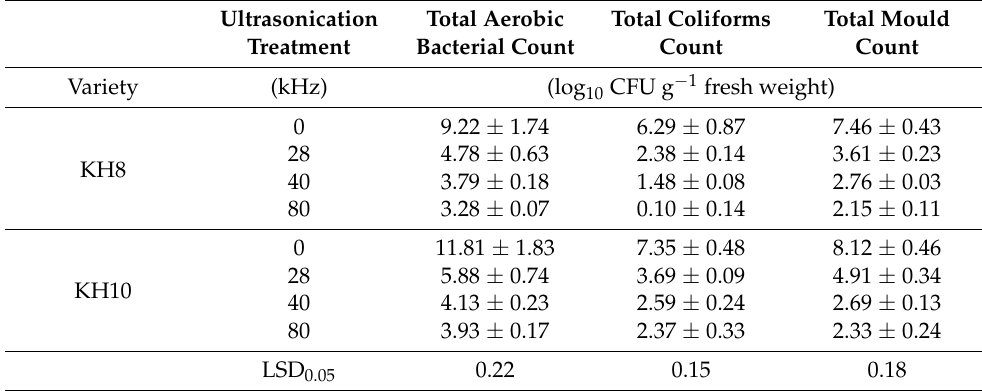
Table 3. Effects of different ultrasonication treatments (28 kHz, 40 kHz and 80 kHz) on the microbial loads of 6-days-old sprouts of two adzuki bean